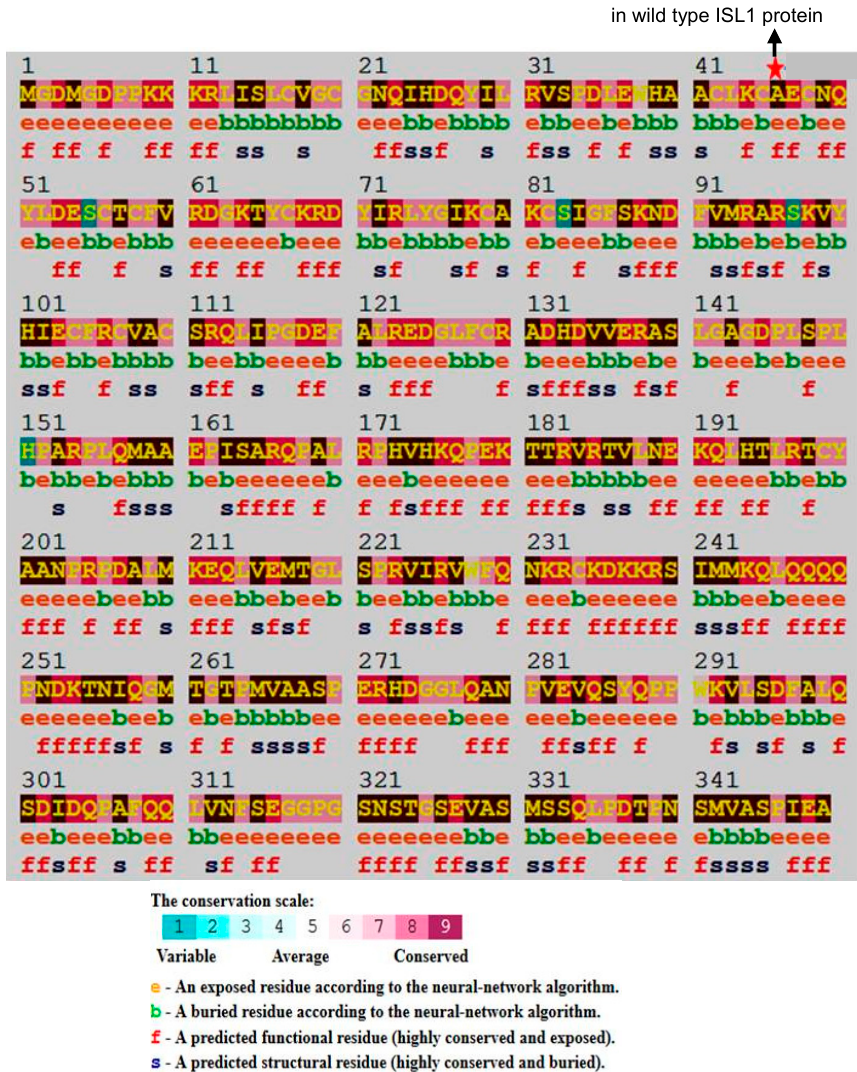
Figure 2. Structural conformation and conservation analysis of p.Ala46Gly. Analysis of evolutionary conserved amino acid residues of p.Ala46Gly by ConSurf. The color coding bar shows the coloring scheme representation of conservation scores.